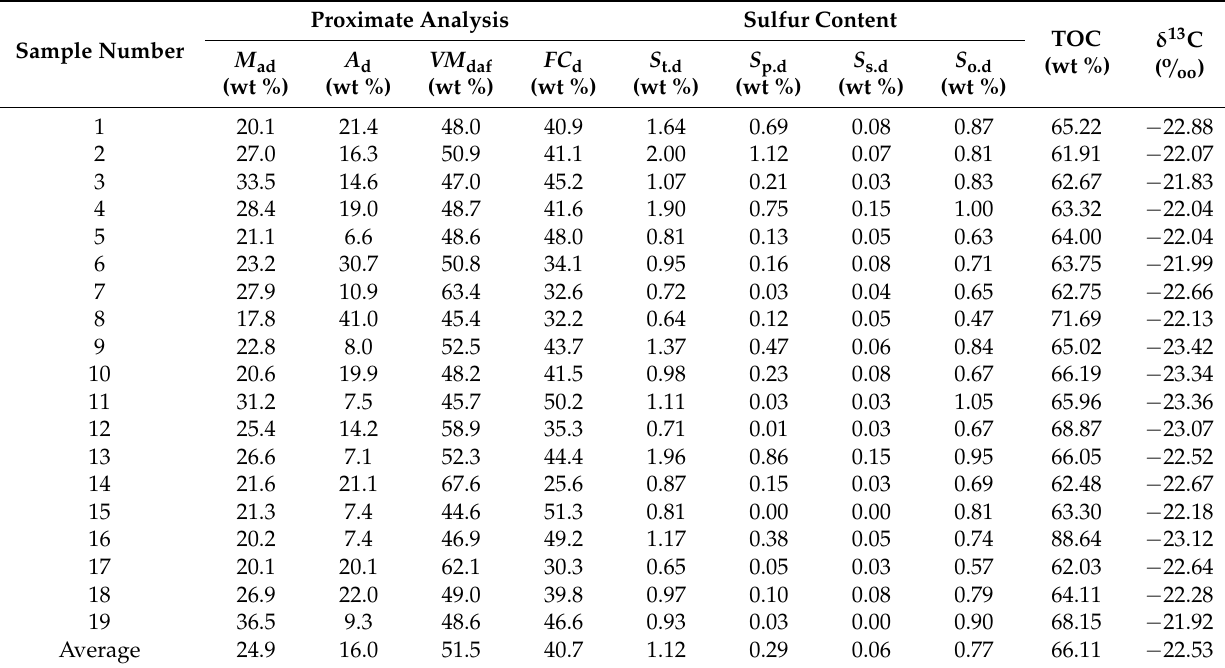
Table 1. Geochemical